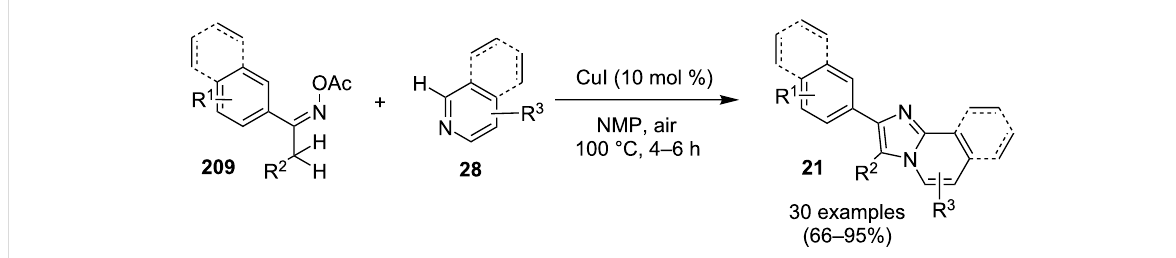
tuted pyridines. However, with 3-methyl and 3-halo-substituted pyridines two regioisomers were obtained in each case where 8-substituted imidazopyridines were the major